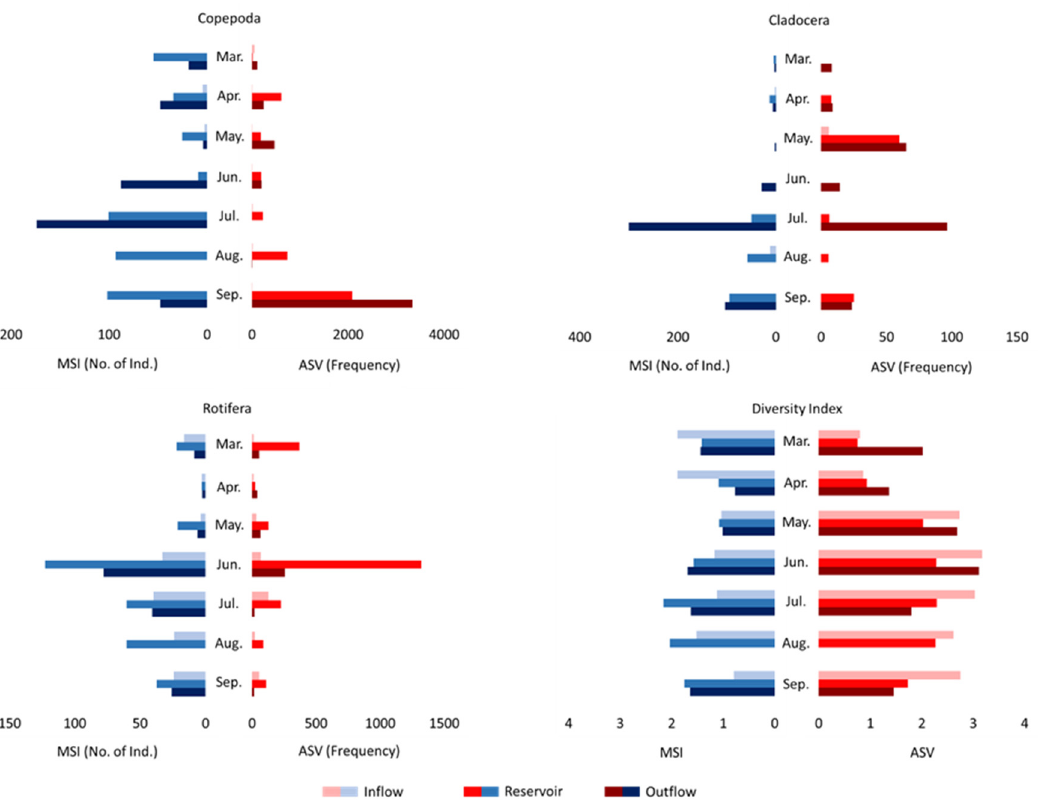
Figure 2. Individual number, ASV frequencies, and diversity indices of zooplankton with two sampling methods (MSI and eDNA metabarcoding) in each sampling site and day.